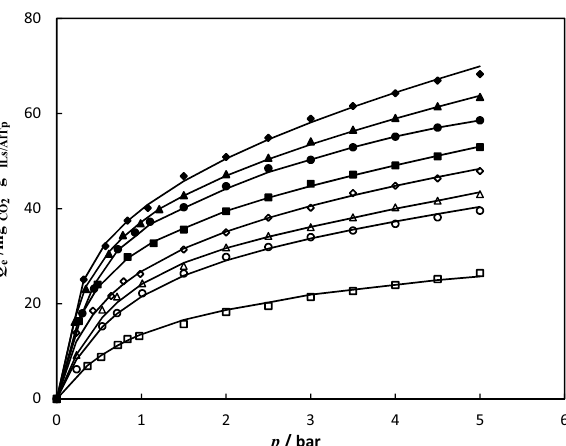
(cid:31)(cid:30) − Q exp CO Q cal CO (cid:30) 2 2 (cid:30) Q exp CO (cid:30) 2